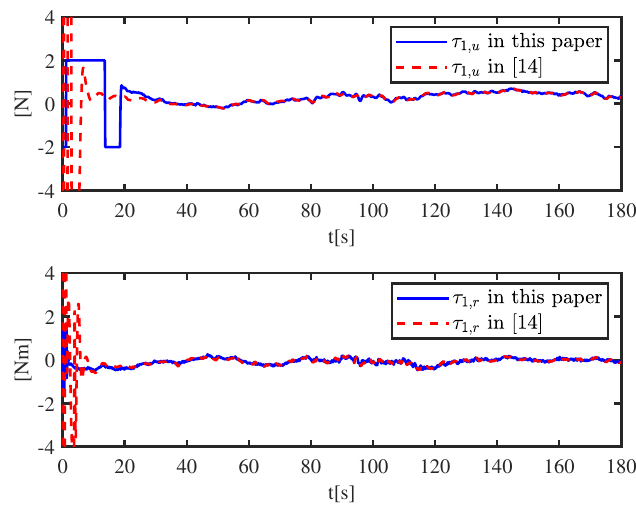
Figure 15. Control input under different controllers.